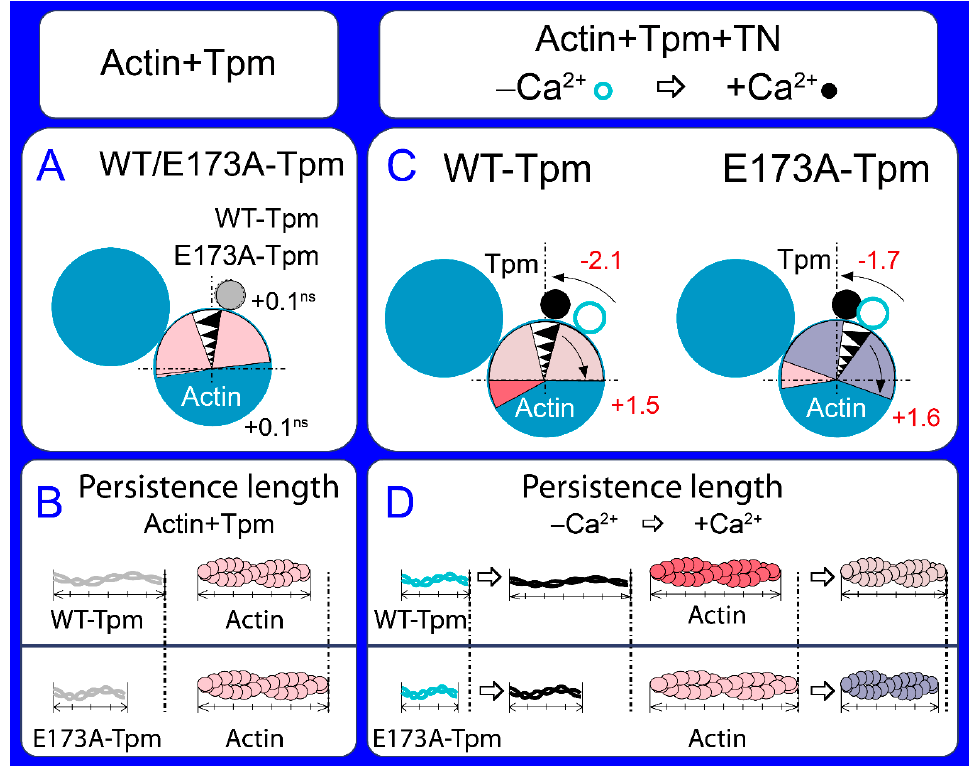
Figure 4. A schematic view of the changes in tropomyosin localization and spatial rearrangements of actin caused by the E173A substitution in Tpm, as follows from the data of polarized fluorimetry. The changes in the value for Φ E (the angle of orientation of the emission dipoles of the probe bound to Tpm or actin monomers) are interpreted as the shift of Tpm relative to the inner and outer domains of actin and the rotation of actin monomers in actin filament. The changes in the value for bending stiffness ε are shown as the alterations in the persistence length of the Tpm strands and actin filament. Ghost fibres were composed of actin and Tpm ( A , B ) or of actin, Tpm and TN ( C , D ). ( A ) The position of the mutant Tpm and actin conformation in the region of the dye binding do not differ from that of the wild-type (WT)-Tpm in ghost fibres containing only Tpm. ( B ) However, the mutation decreases the persistence length of Tpm and increases that of actin. ( C ) The effect of the mutation emerges in the presence of troponin—at low Ca 2+ Tpm shifts towards the inner domains of actin and actin monomers switch on. ( D ) The persistence length is lower for the mutant Tpm than for the WT-Tpm. The increase in the persistence length for WT and mutant Tpms during the rise of Ca 2+ concentration is followed by the decrease in this parameter for actin. Designations: The changes in Φ E at high and low Ca 2+ are shown by numbers ( C ), the direction of the rearrangements is depicted by arrows. The changes in Φ E (shown by numbers with symbols “ns”) are non-significant in the absence of troponin ( A ). Different conformational states of actin and localization of Tpm and respective persistence length of actin and Tpm are depicted by different colours.